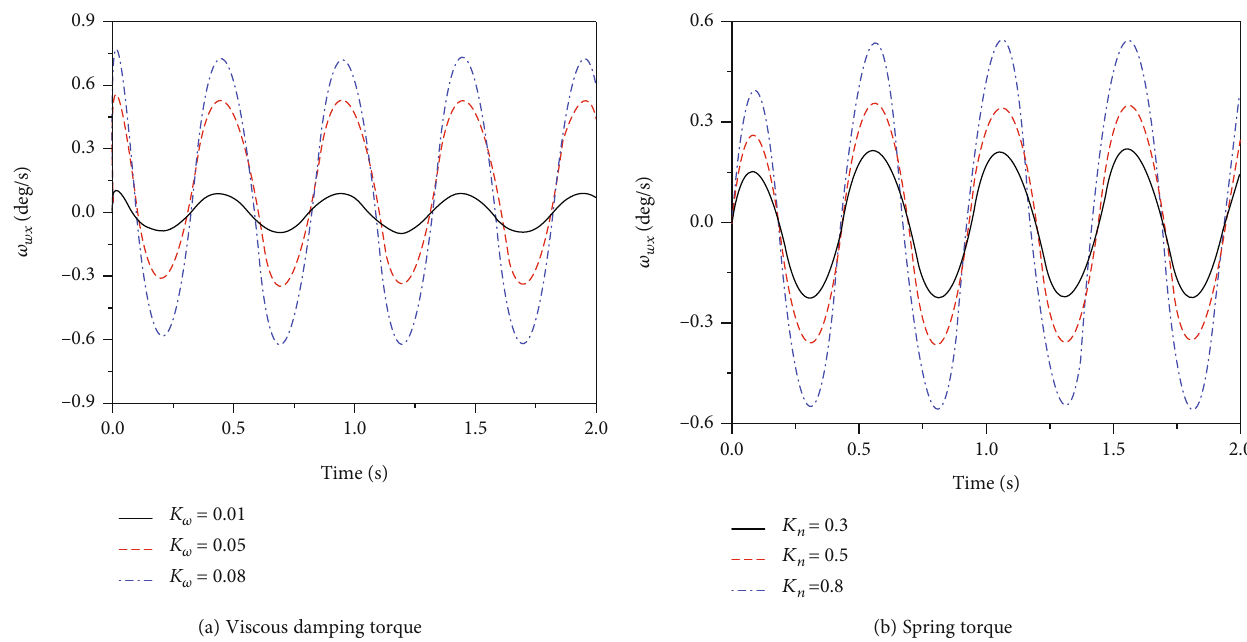
Figure 6: DRR of the pitch interference